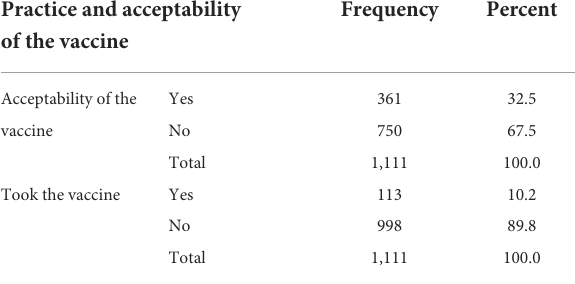
TABLE 4 The acceptance and practice of COVID-19 vaccination among study